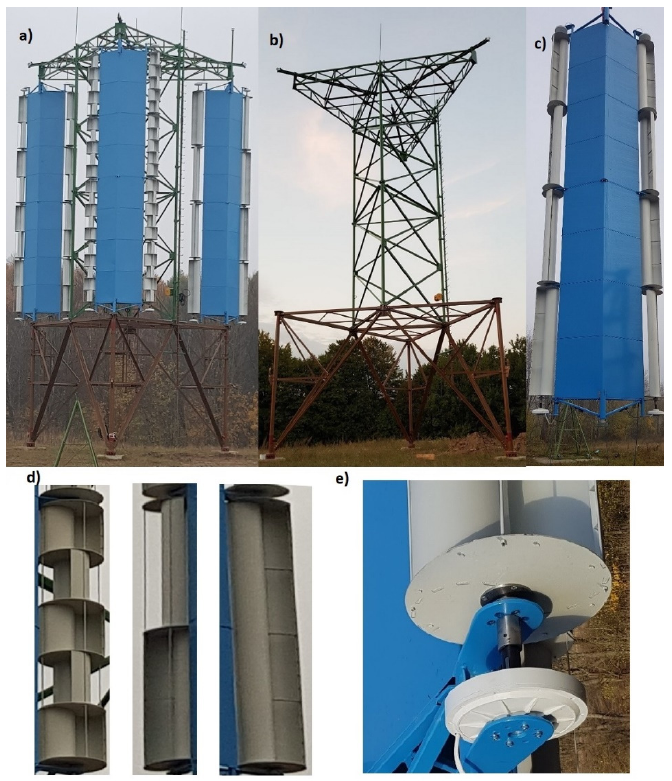
Figure 2. ( a ) Wind turbine; ( b ) wind turbine tower; ( c ) wind turbine structure; ( d ) rotors 1-, 2-, 5-moduls; ( e ) generator. Each turbine contained two rotor columns divided in half into two sections. One sin-